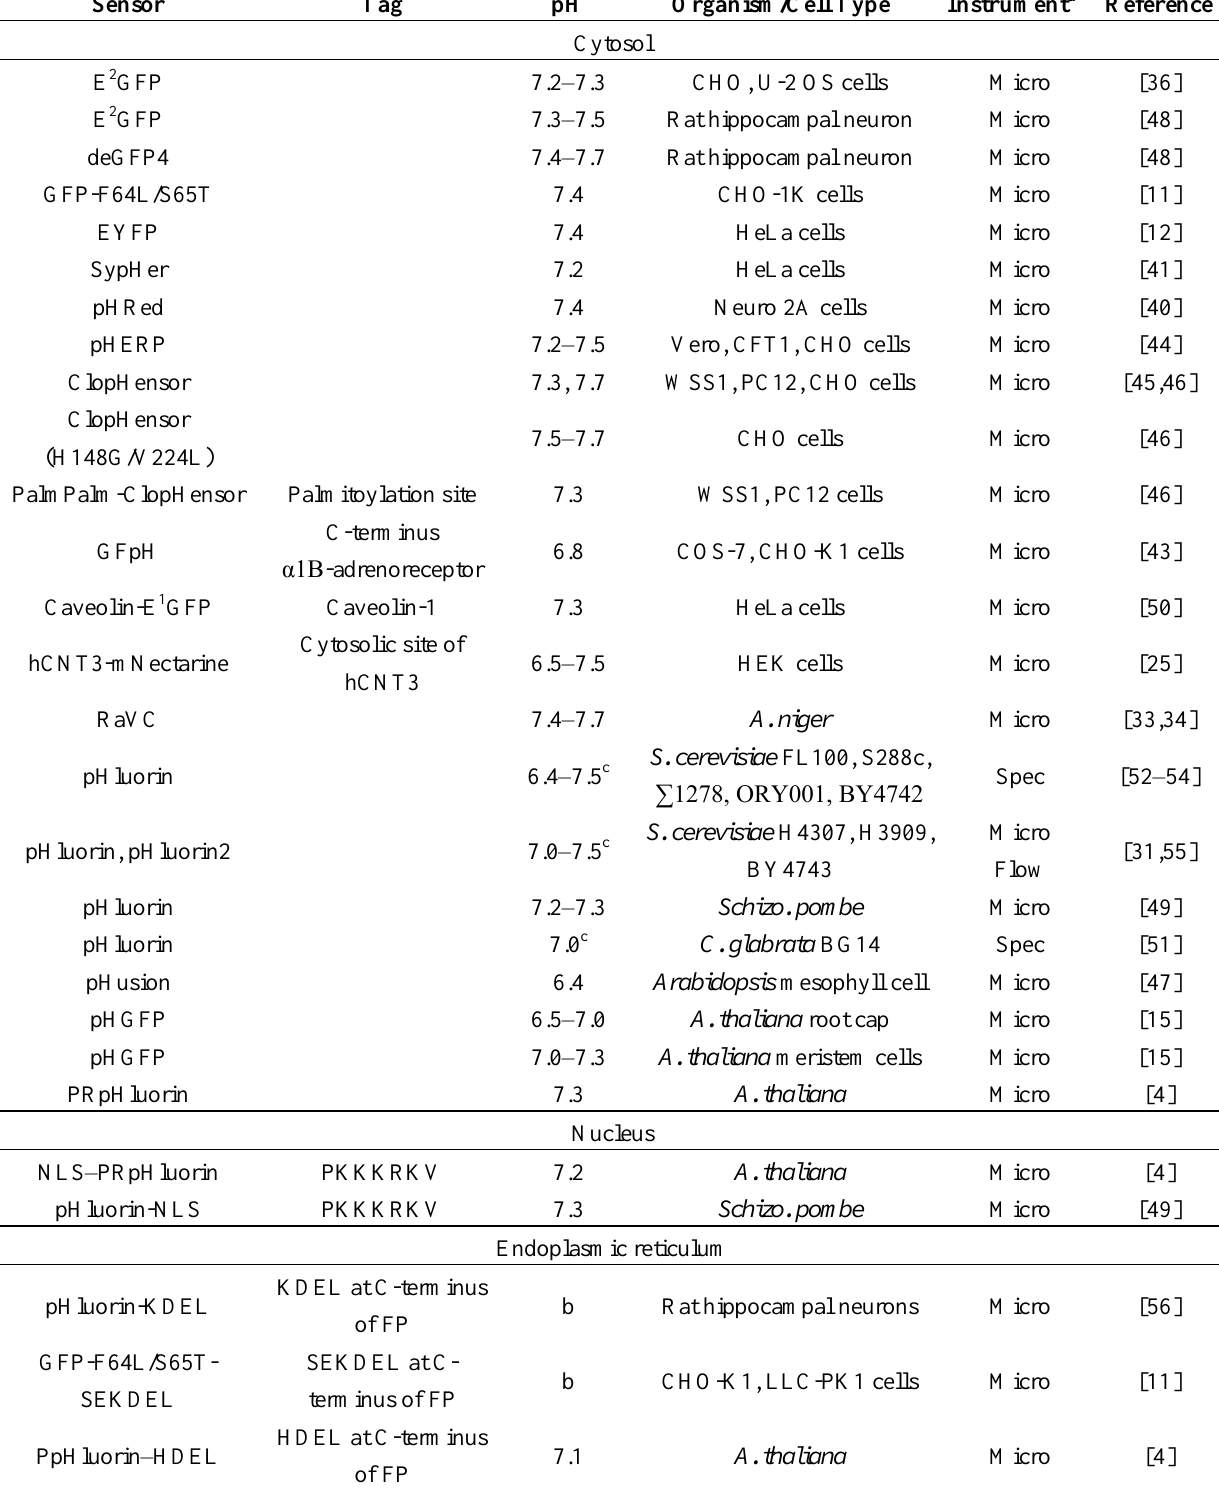
Table 4. Select examples of pH-sensitive FPs targeted to cytosol, nucleus, and endoplasmic